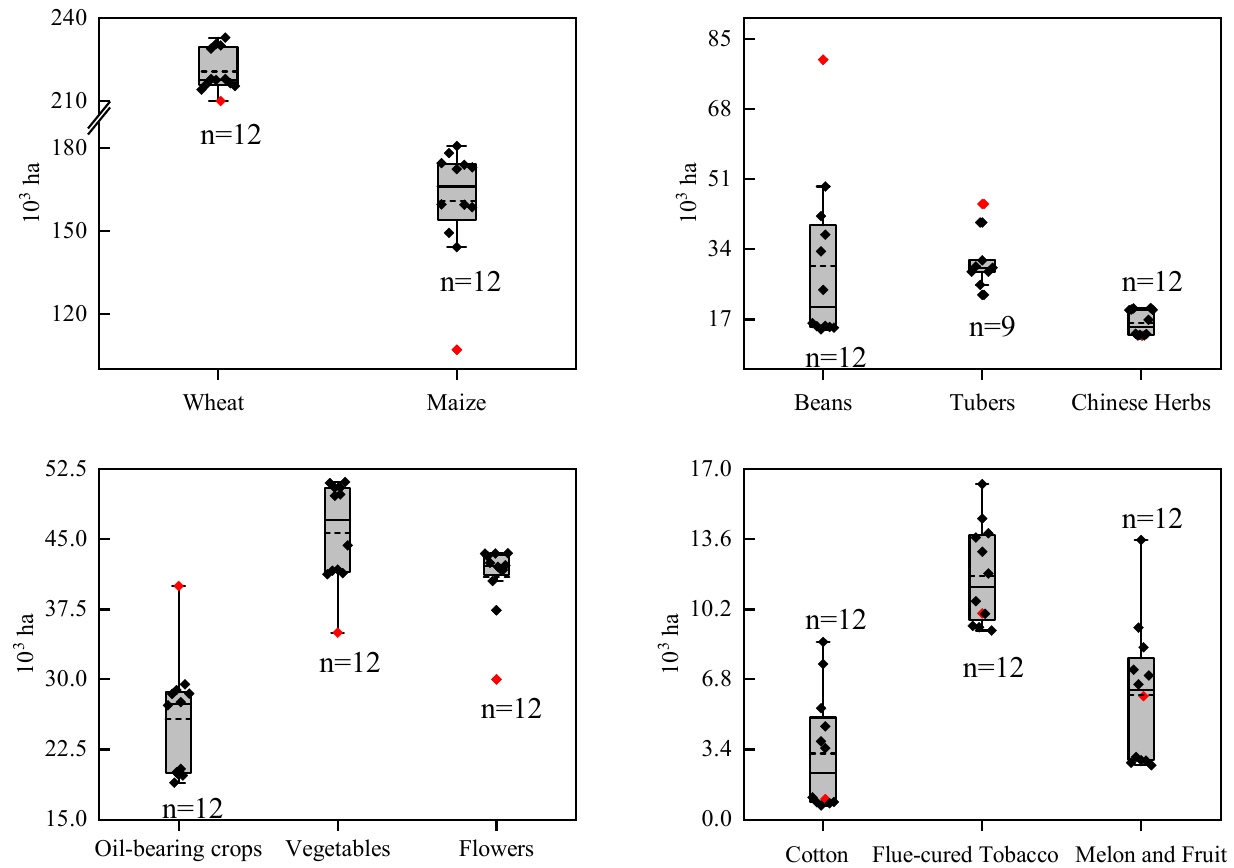
Figure 7. Adjustment scheme of water-saving planting structure based on IQR method. Black and red dots indicate before and after planting areas adjustment over investigated years.